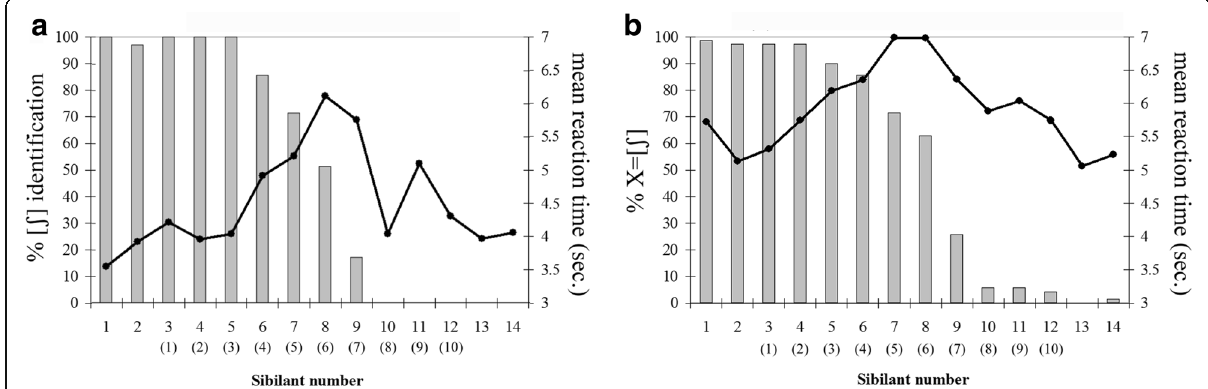
Fig. 3 Results of the identification test ( a ) and discrimination test ( b ) pooled across all ten listeners and five stimulus repetitions. Bars indicate percentages, solid lines show mean reaction times. Each value in a represents 50 responses and each value in b 100 responses (due to five repetitions in the AXB and BXA order). The numbers in brackets refer to the sibilant and stimulus numbers in the actual